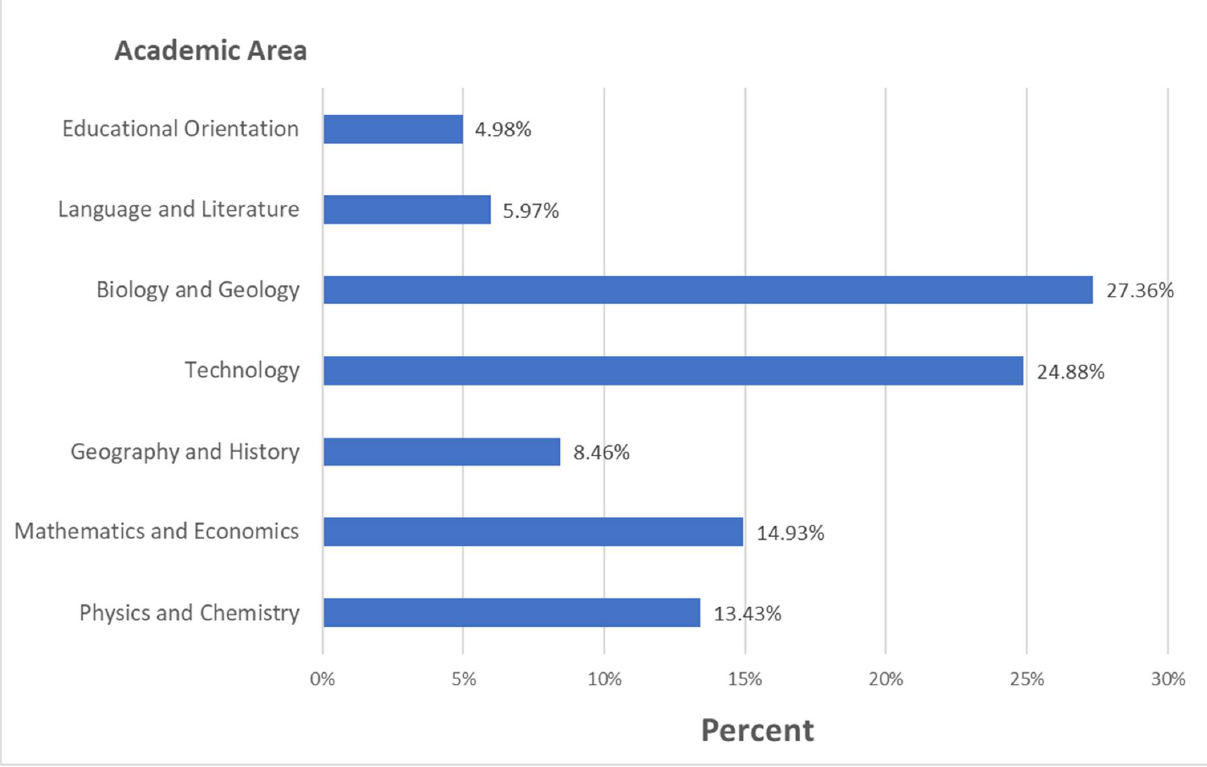
Figure 2. Sample distribution according to academic area.